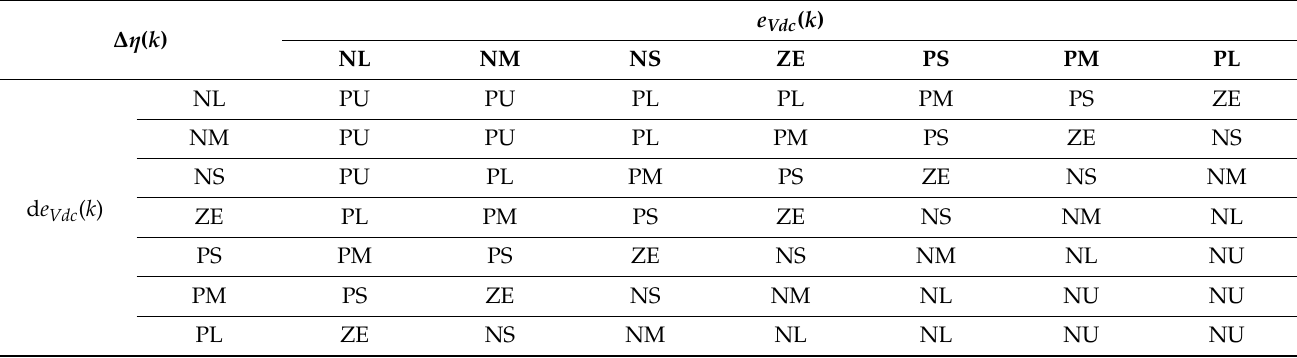
Table 5. Fuzzy association rules for